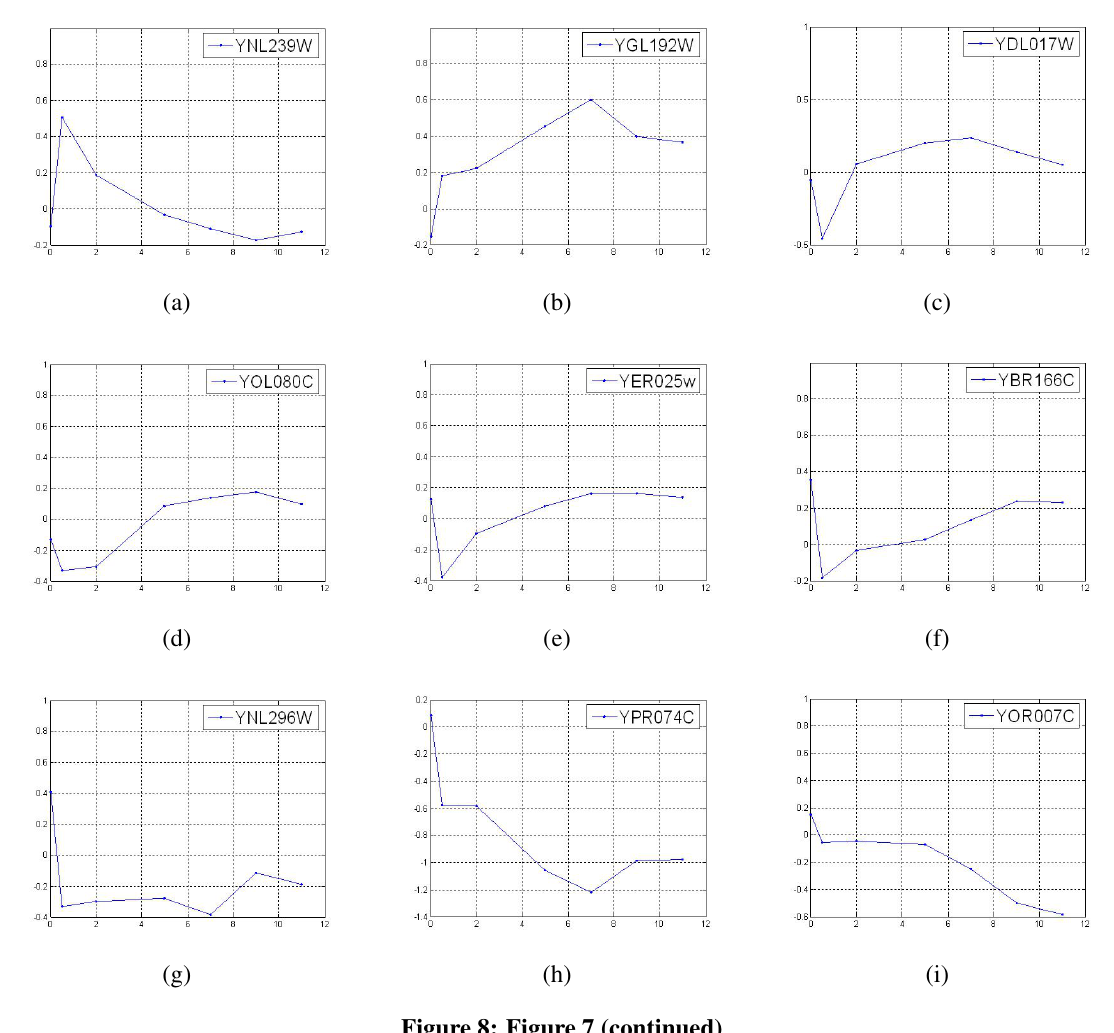
Figure 8: Figure 7